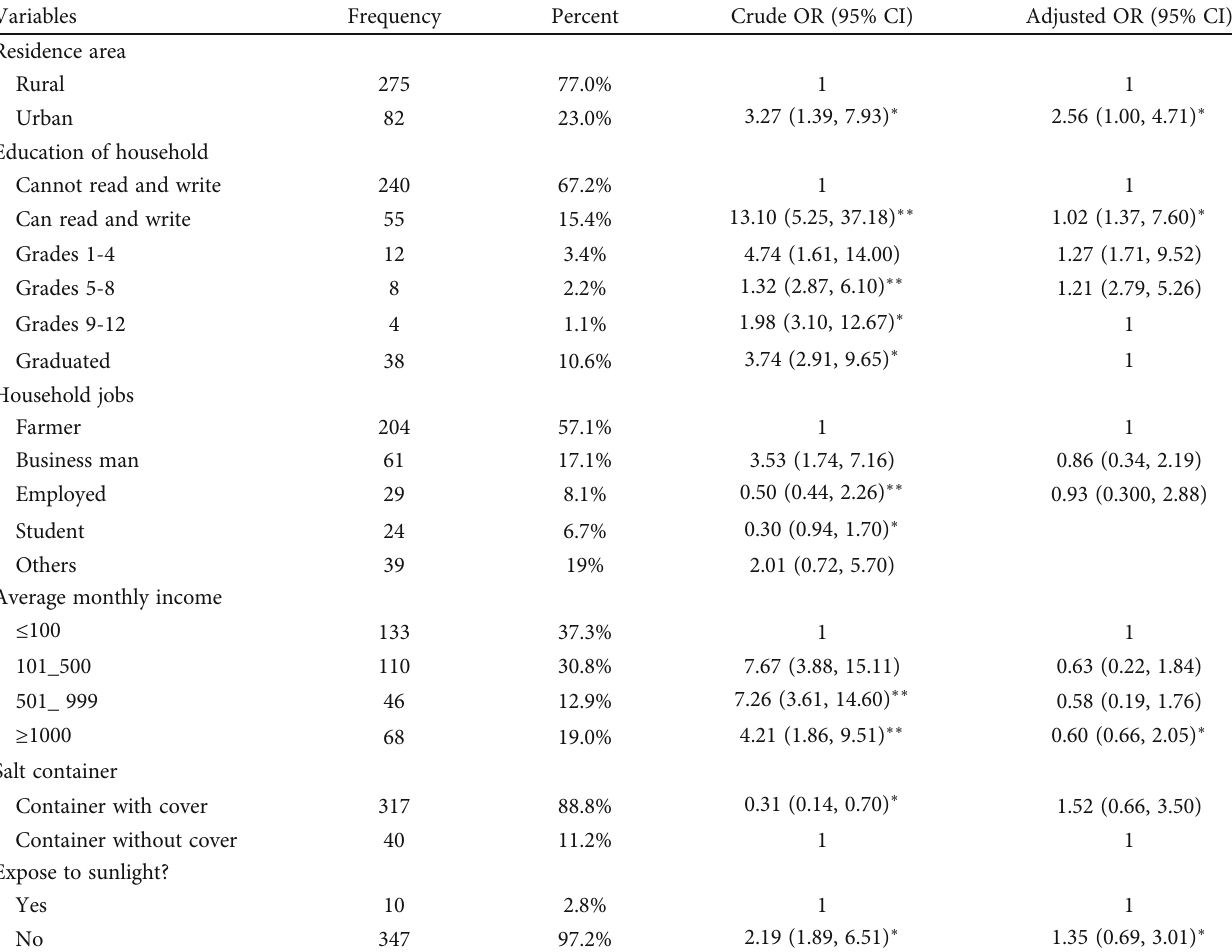
Table 7: Factors associated with availability of iodized salt in the study